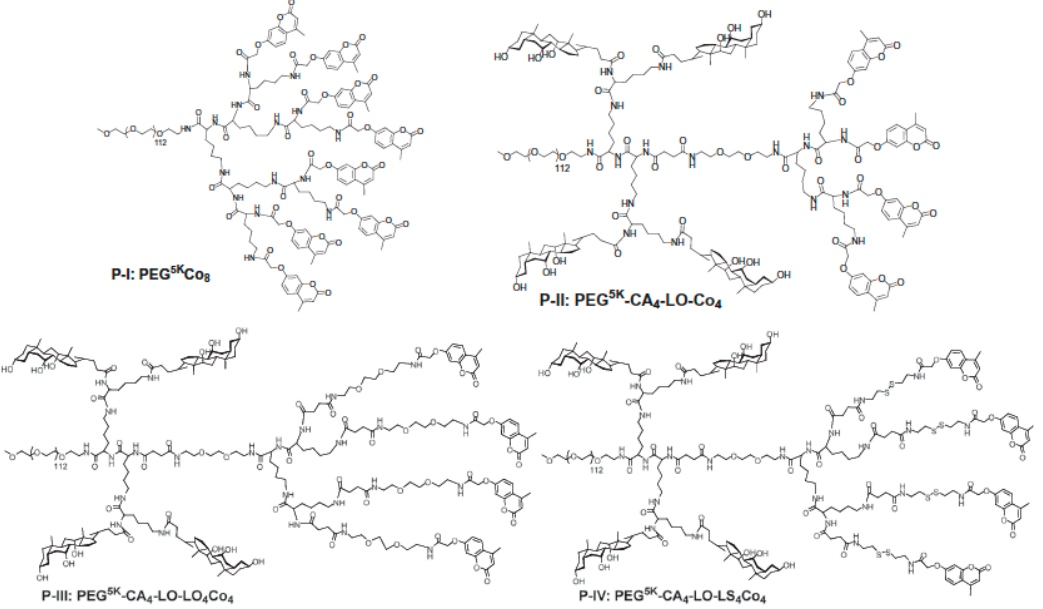
Figure 8. PEG-poly(lysine) telodendrimer with different backbones and a variety of functional groups. Reprinted with permission from [188]. Copyright 2015 Elsevier.